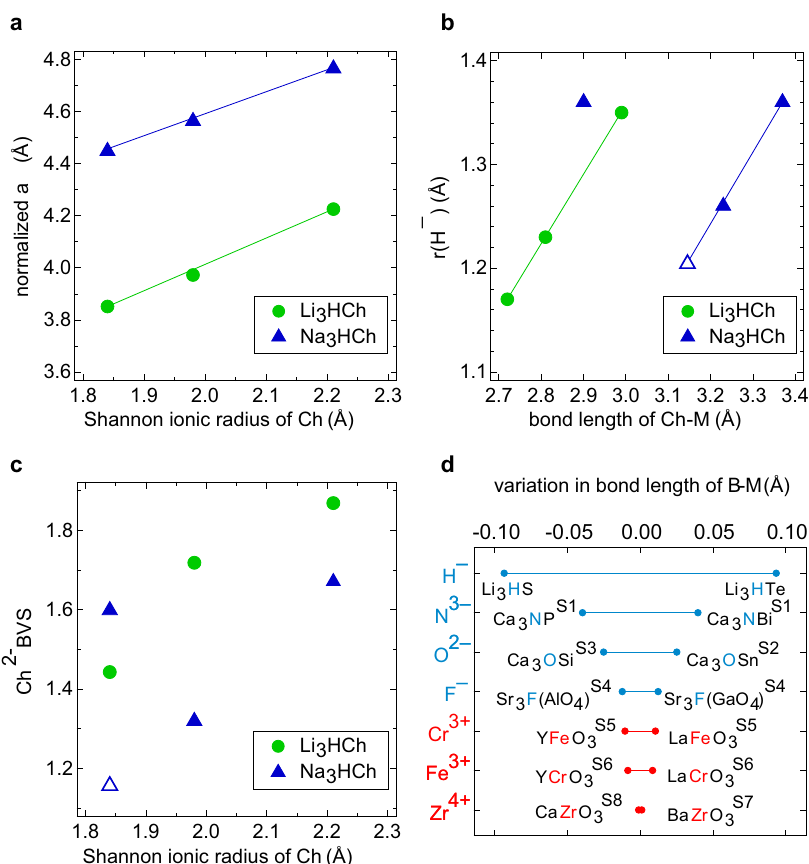
Fig. 3 Structural features of M 3 HCh antiperovskites (M = Li, Na). a Normalized (cubic) lattice parameters of M 3 HCh. For orthorhombic o-Na 3 HS, the cubic lattice parameter is an average of normalized lattice parameters. Lines are for the eye guidance. b The hydride anion (H – ) size obtained by subtracting M + radius from H – – M + bond length. Open triangles indicate the ionic radius of H – in hypothetical cubic c-Na 3 HS, which is calculated by using the average normalized cubic lattice parameter of the orthorhombic o-Na 3 HS. c BVS values for Ch 2 – . Open triangles indicate the S 2 – BVS for hypothetical cubic c- Na 3 HS. d Variation in bond length of B – M in BM 6 (B = H – , N 3 – , O 2 – , F – ) octahedra for M 3 BA antiperovskites and B – O in BO 6 (B = Fe 3 + , Cr 3 + , Zr 4 +